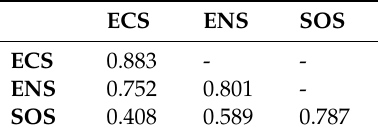
Table 6. Fornell–Larcker